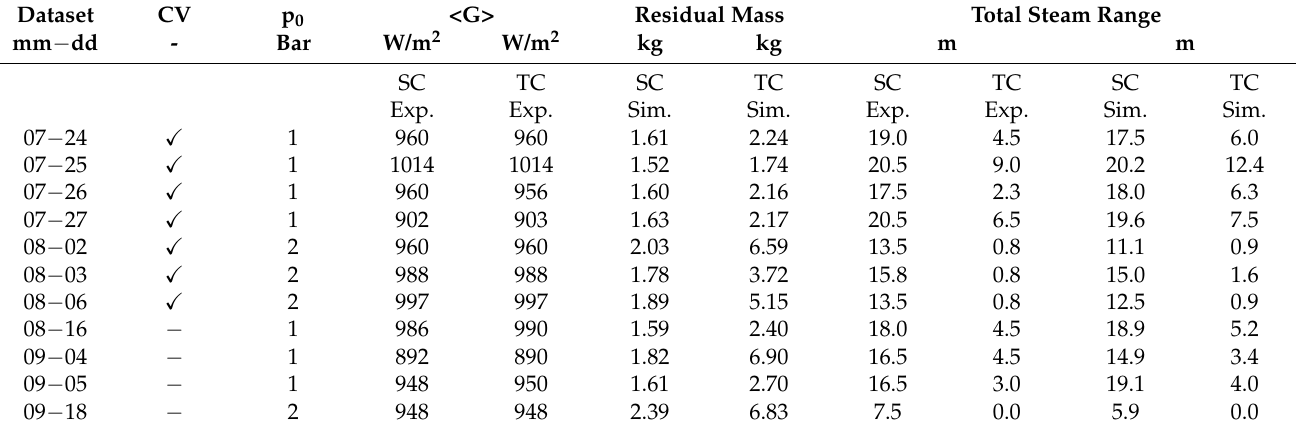
Table 2. Average irradiation on the system with the standard selective (SC) and thermochromic (TC) absorber coating. Experimental and simulation results of the total steam range and simulation results of the residual mass. Active check valves (CV) are indicated by “ (cid:88)